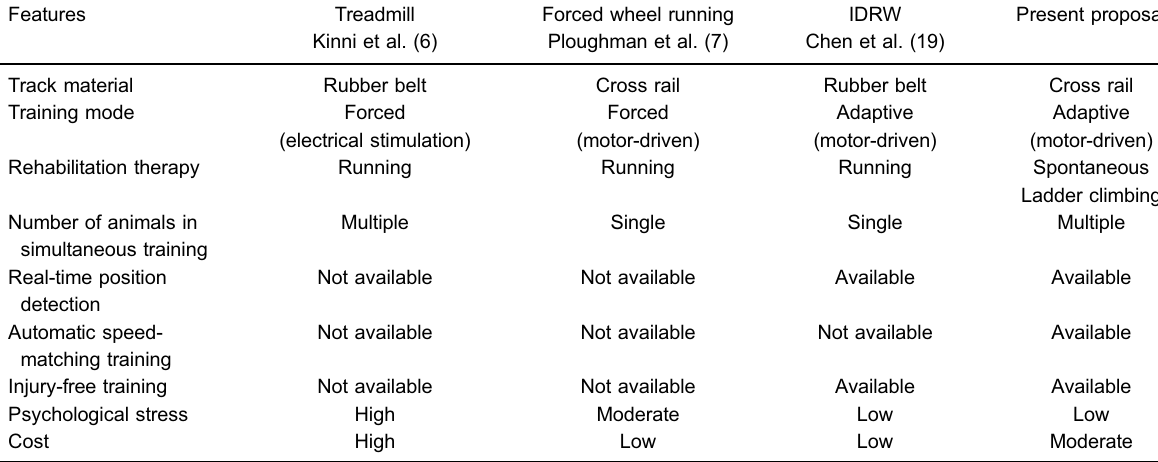
Table 3. Comparison of major features among animal rehabilitation platforms used in the respective studies.